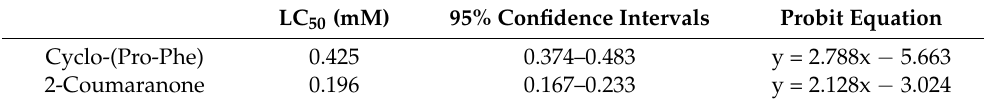
Table 3. LC 50 values of 2-coumaranone and cyclo-(Phe-Pro) against PWN for 24 h.